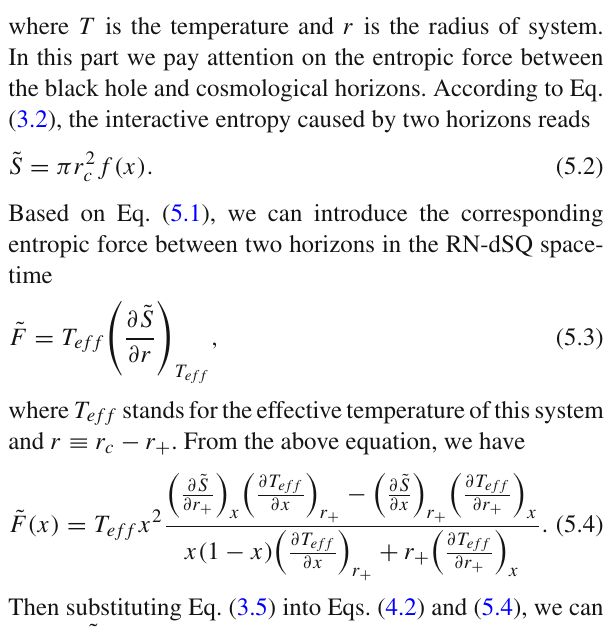
− T β − T ef f , ef f , and eff